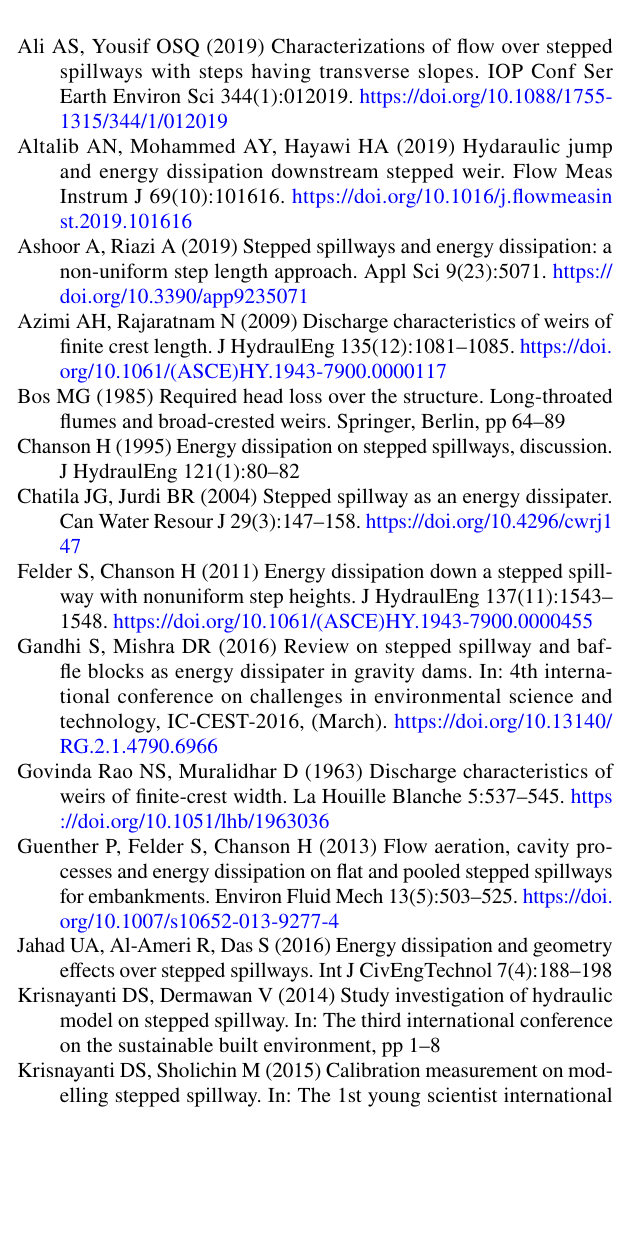
Fig. 9 Comparison between the discharge coefficient in present work and calculated from previous